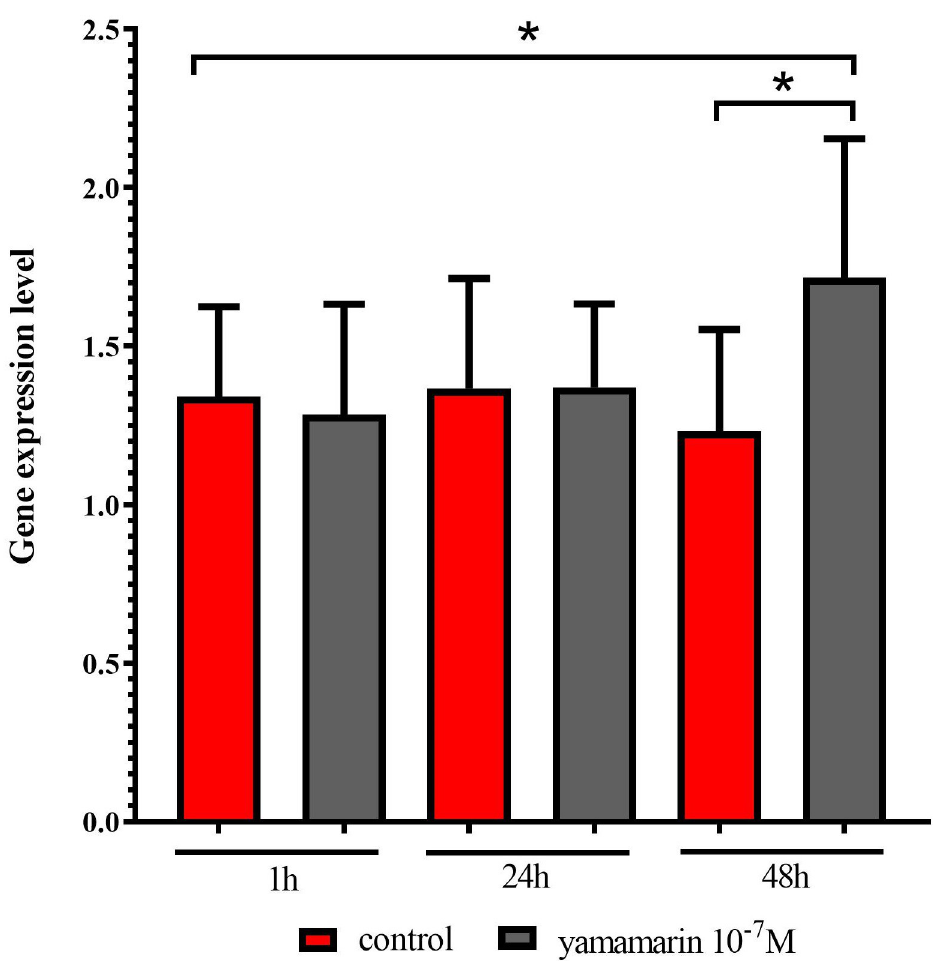
Fig 7. The expression level of vitellogenin in female fat body tissue 1 h, 24 h and 48 h after injection, was calculated by the ΔΔ Ct method (reference syntaxin-1 ). The data represent mean value ± SD from 4 independent biological (each biological sample consisted of tissue isolated from � 10 females) and 3 technical repetitions. Statistical significance was tested with Kruskal-Wallis H = 15.49 and Mann-Whitney test (1 h control and 48 h yamamarin U = 37.0, 48 h control and 48 h yamamarin U = 25.0). Significant differences are indicated by asterisks as indicated: p � 0.1 ( �